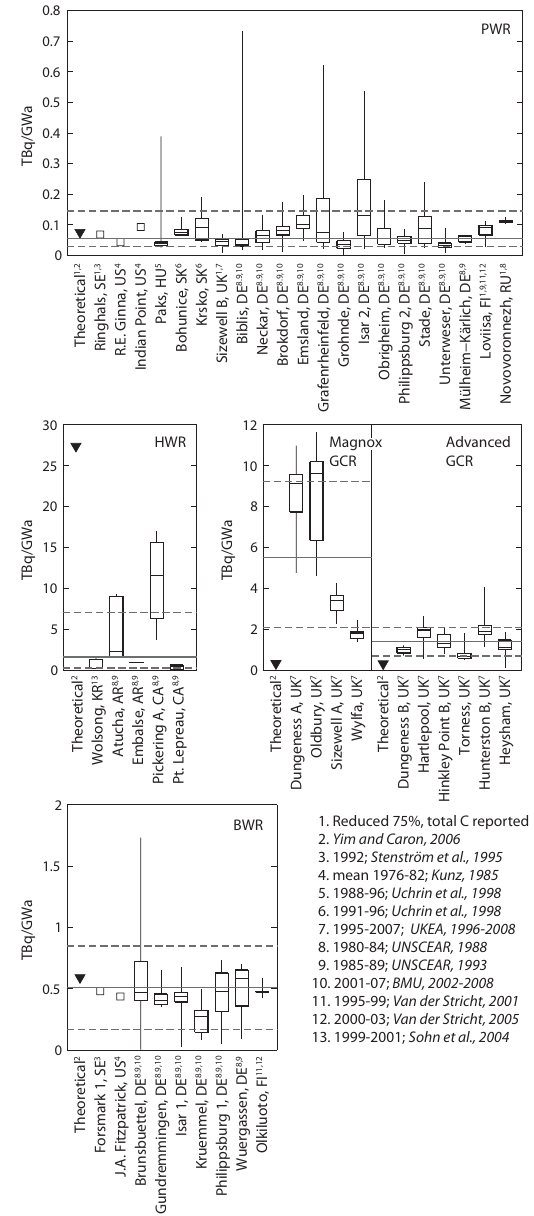
Fig. 1. Emission factors of 14 CO 2 release per electrical energy out- put at nuclear reactors of Pressurized Water Reactor (PWR), Heavy Water Reactor (HWR), Magnox and Advanced Gas-Cooled Reactor (GCR) and Boiling Water Reactor (BWR) types. Triangles indicate theoretical emission factors from Yim and Caron (2006). Observed emission factors at individual nuclear sites are shown as squares when one year or one multi-year average observation of 14 CO 2 release was reported, or as boxplots when several years of annual mean observations were reported. Dashed lines show 70% confi- dence intervals. Emission factors at PWRs footnoted with a “1” reported total 14 C release and were reduced by 75% to account for 14 CH 4 emissions. Other footnotes indicate the periods of obser- vation and references. Solid lines show emission factors used, as listed in Sect.